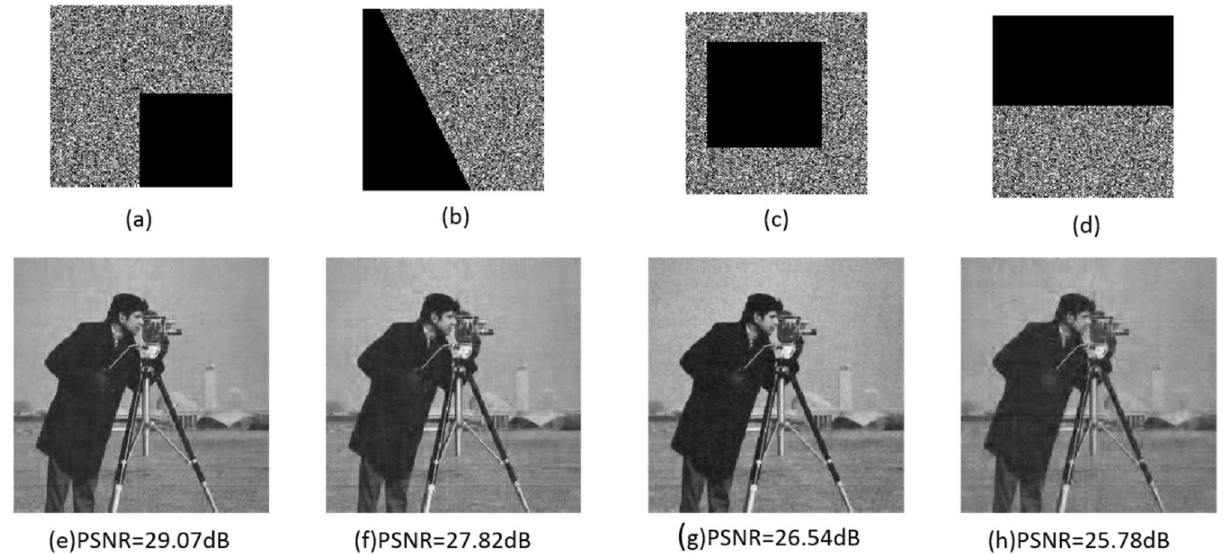
Figure 10. Result of cropping attacks: ( a – d ) encrypted images with different cropping attacks; ( e – h ) the decrypted images from ( a – d ),